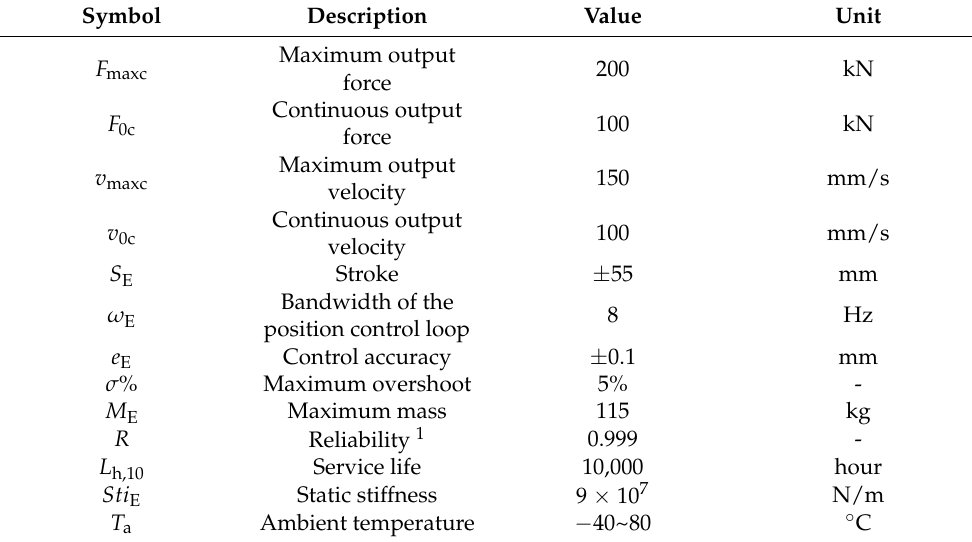
Table 1. The system-level performance requirements of a 30 kW EHA